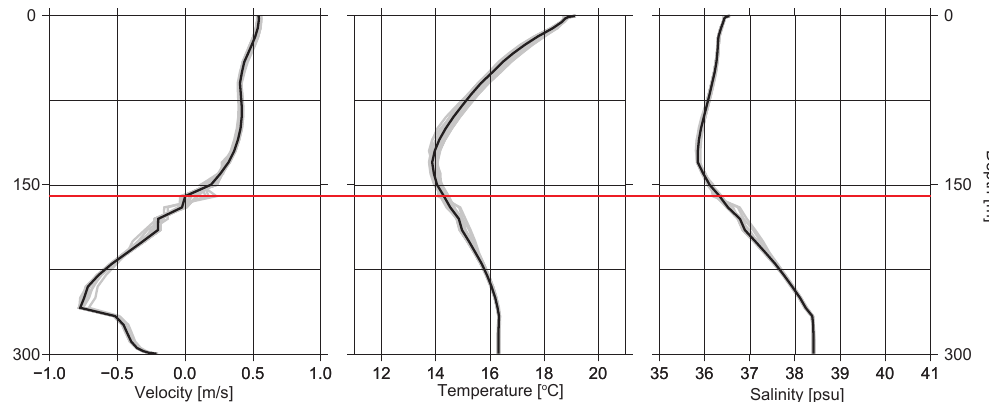
Figure 3. Vertical profiles of zonal velocity (left), temperature (middle), and salinity (right) in the middle of the Strait of Gibraltar in the reference experiment. Grey shading in each frame indicates the range of variation of the variable in the last 100yr of integration, the solid black line is the average over the same 100yr. The red line indicates the depth of the interface between inflow and